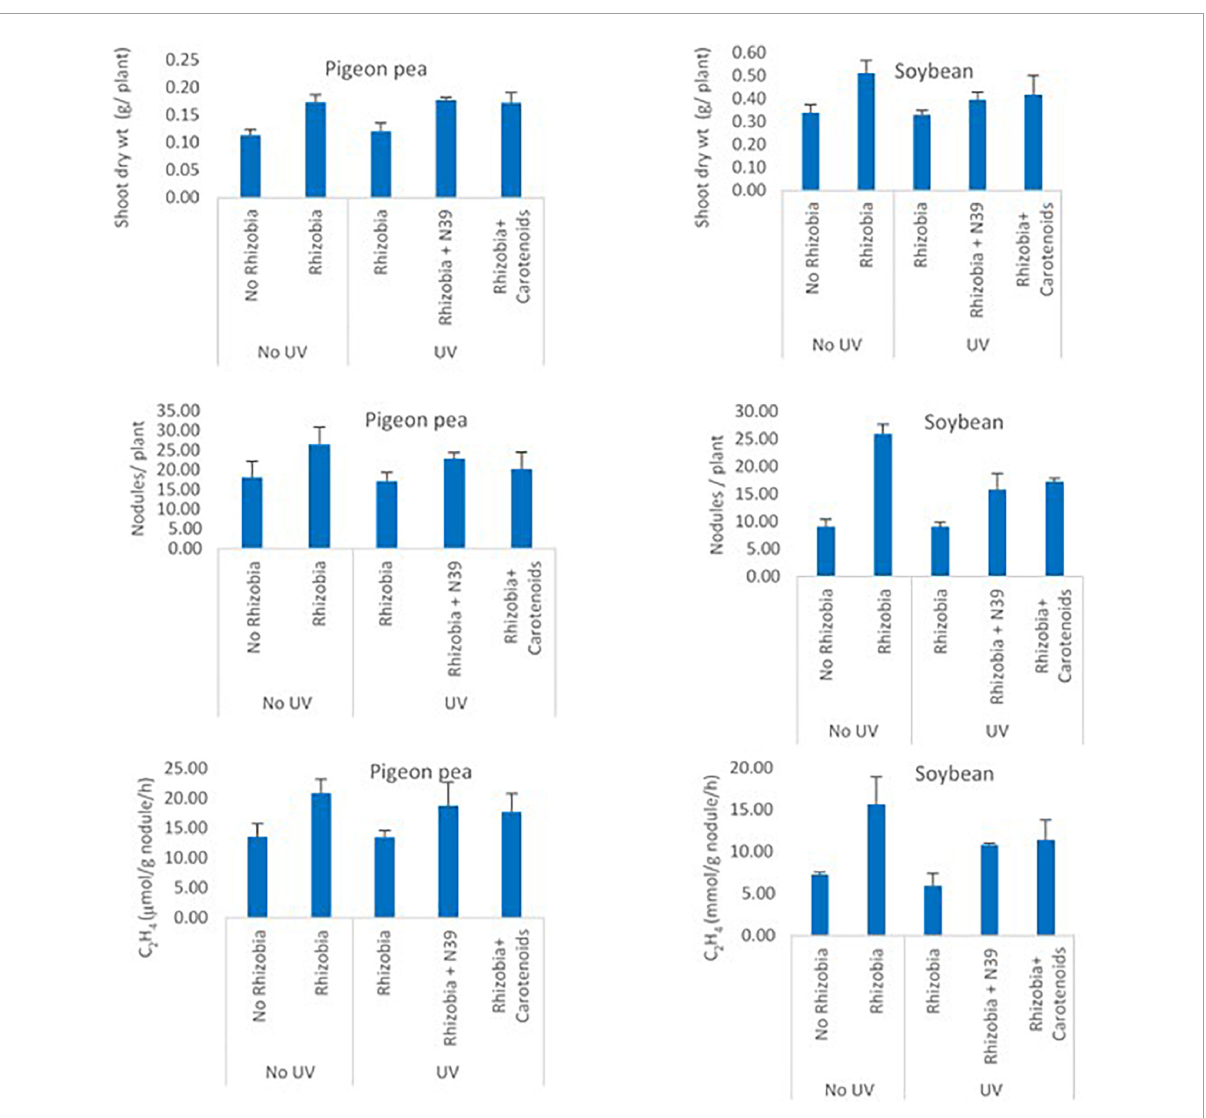
FIGURE7 Effect of Methylobacter sp N39 and carotenoid extract on plant–rhizobium interaction in response to UV irradiation. Seeds of pigeon pea and soybean were prepared with the following treatments. 1 - control (no rhizobium no UV), 2 - rhizobium no UV, 3 - rhizobium with UV, 4 - rhizobium + Methylobacter sp N39 with UV, and 5 - rhizobium + carotenoid extract with UV. After treatments seeds were air dried and UV irradiated for 15 min. Seeds were planted and grown under controlled condition. Plants were harvested after 30 days of sowing and parameters (shoot dry weight, number of nodules, and acetylene reduction assay) were estimated. Y -axis represents parameters, and X -axis represents treatments. Values are presented as arithmetic mean ± standard deviation of three replicated